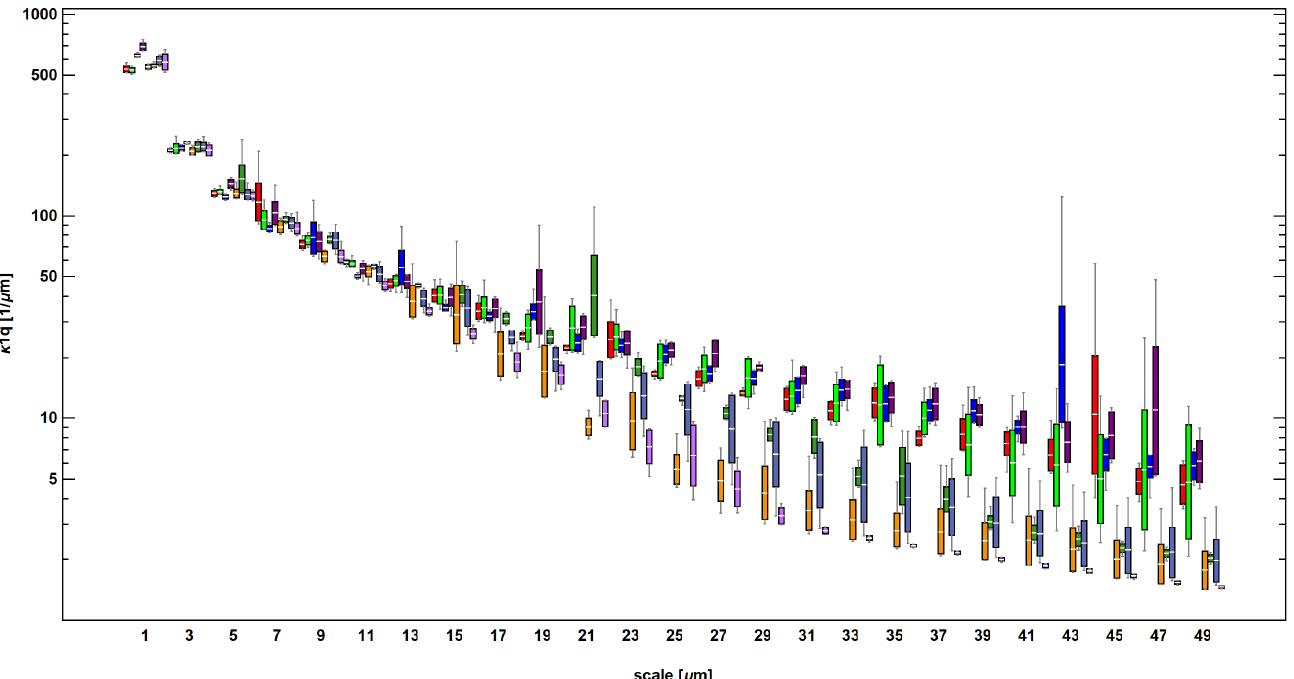
Figure 10. Evolution of standard deviation of maximum curvature (κ1q) as a function of scale.